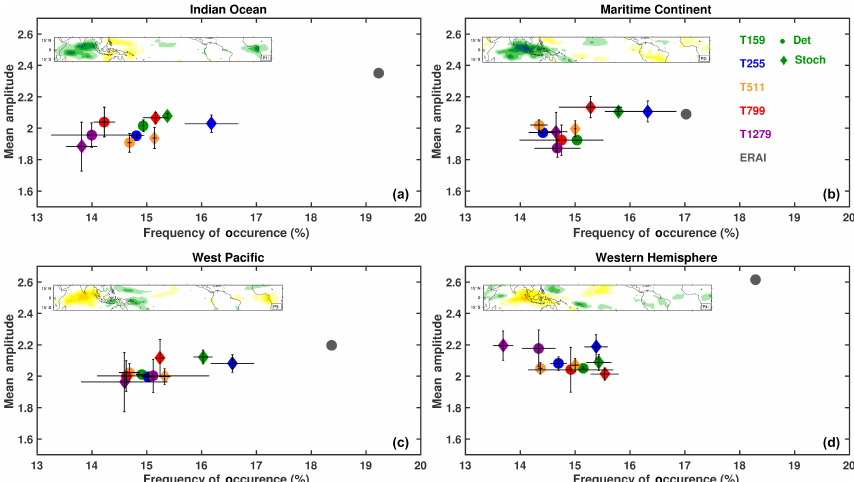
Figure 8. MJO frequency of occurrence vs. mean amplitude for the PDA experiments in the four different phases given the MJO amplitude to be > 1. The four phases are classified as Indian Ocean (a) , Maritime Continent (b) , western Pacific (c) and western hemisphere (d) , and their geographical location is shown by the boxes at the bottom of each panel with anomalous positive/negative precipitation patterns (green/yellow regions). Colours indicate the ensemble mean of the different resolutions as shown in the legend, where the circles are the deterministic runs and the diamonds the stochastic runs. ERA-Interim is reported in grey. Statistics are shown for the period 1980–2001. Error bars show the uncertainty range by providing the same statistic for periods half the length of the